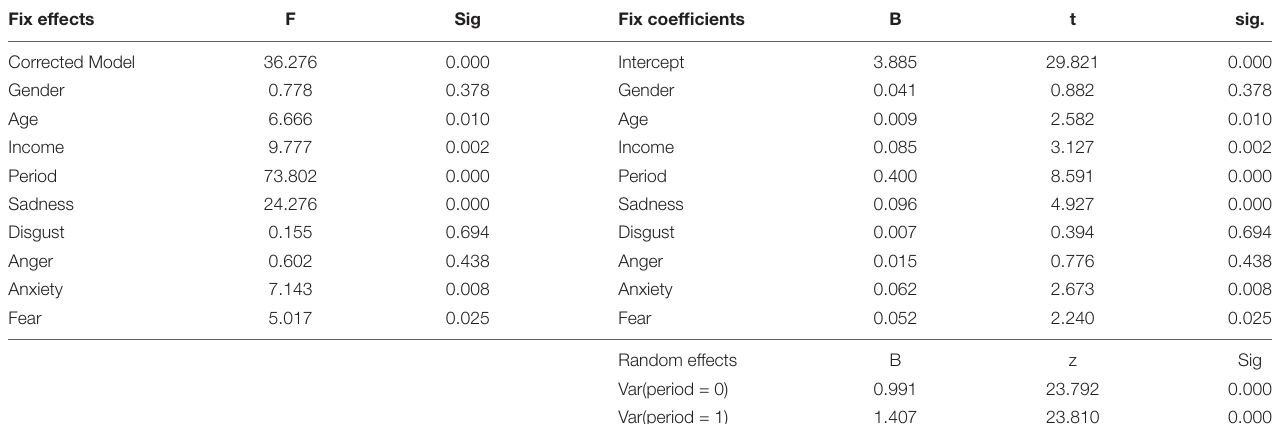
TABLE 1 | Effects of emotions on coping strategy of independent information focus.